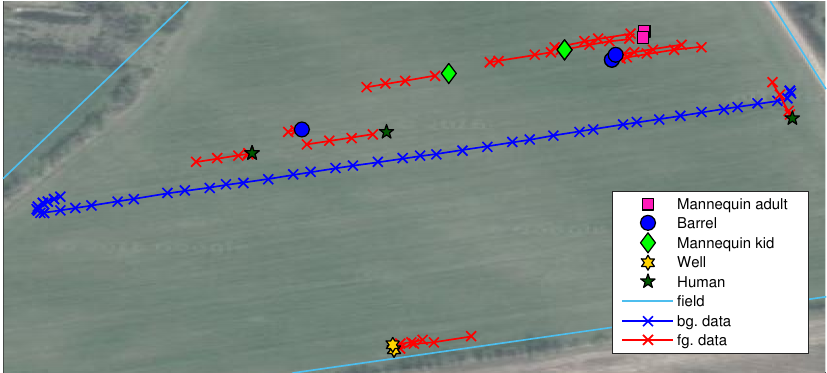
Figure 4. Obstacles and tractor image positions for background data (blue) and test data (red). Orthophoto from Google